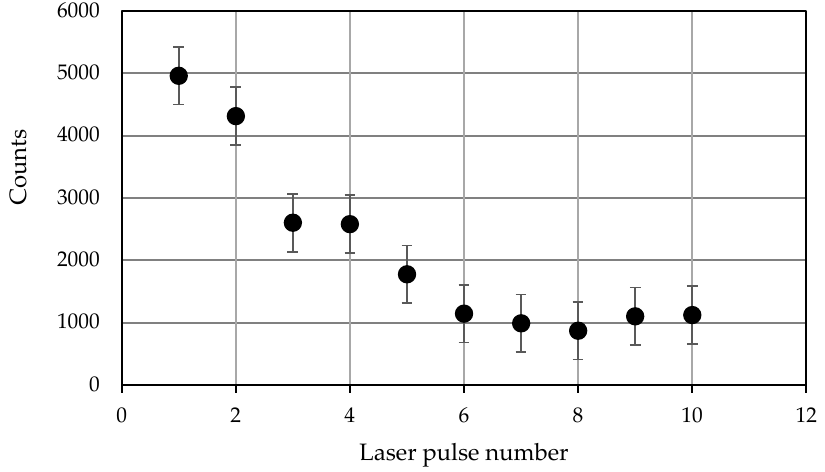
Figure 8. Peak intensity of the carbon line C I 247 nm for the Ti6Al4V alloy.